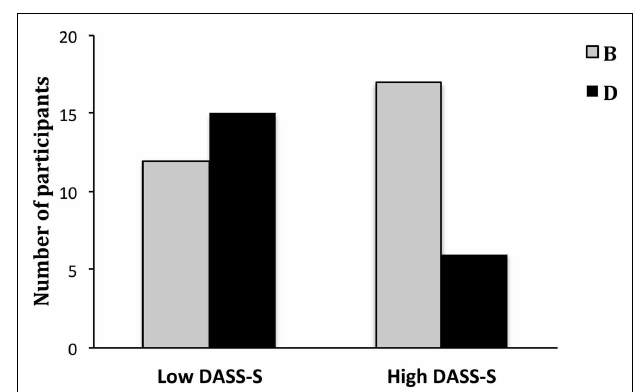
FIGURE 2 | Number of participants choosing a chocolate bar depicting either CS B or CS D in the forced-choice behavioral test according to DASS-S group